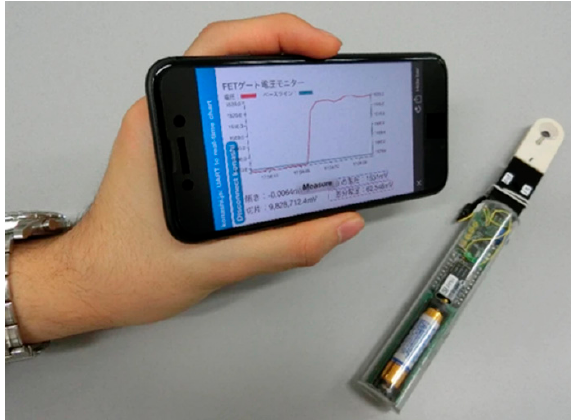
Figure 17. Portable biosensing system using a Bluetooth connection between a smartphone and the field-effect transistor-based biosensor. Reproduced with permission from [131].